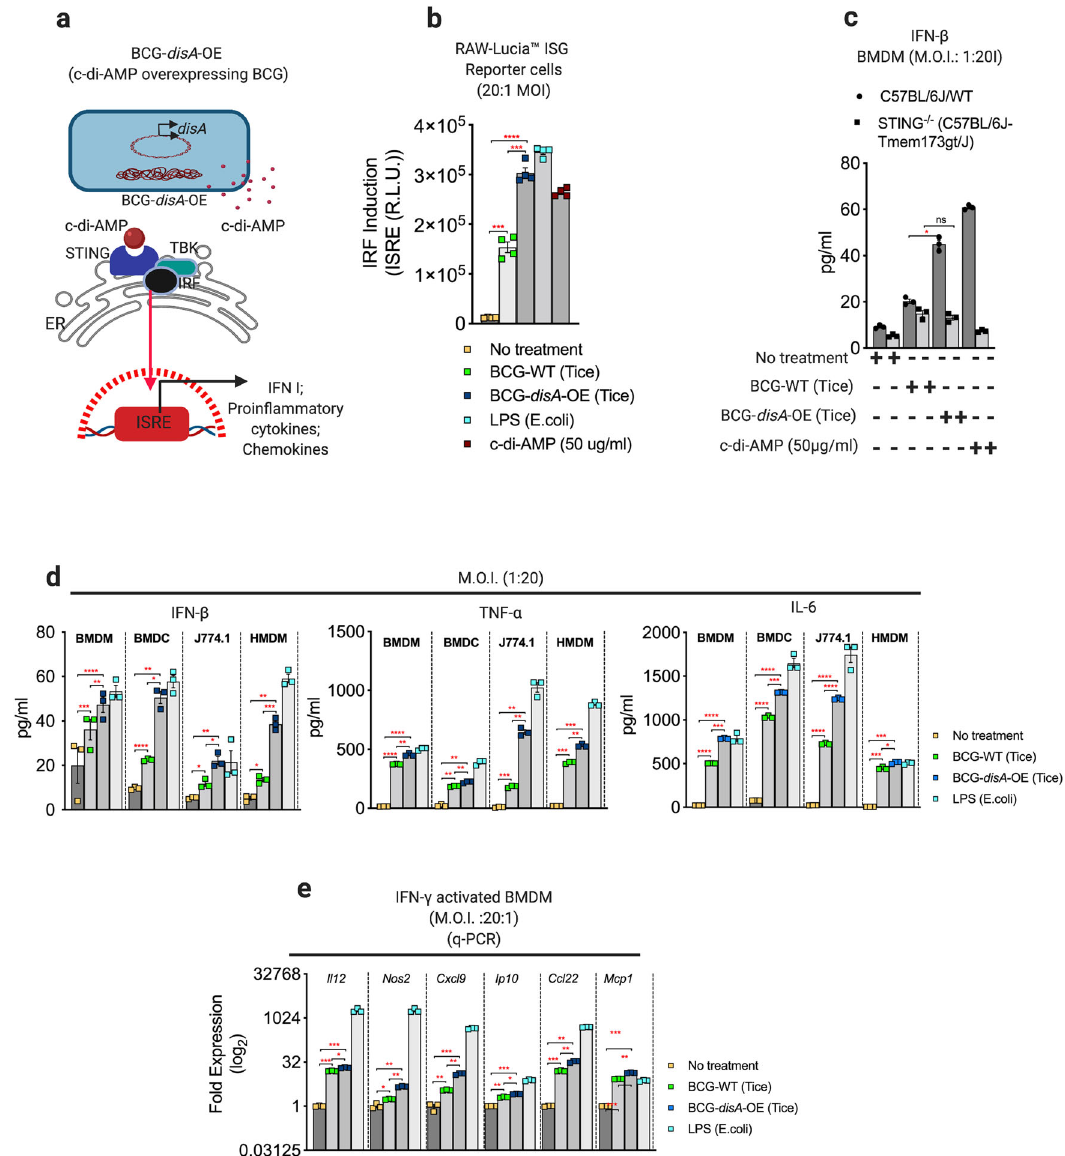
Fig. 1 BCG- disA -OE elicits greater pro-in fl ammatory cytokine responses than BCG-WT in primary human and murine macrophages and dendritic cells in vitro. a Schematic diagram. b IRF3 induction measured in RAW-Lucia ISG reporter macrophages. c IFN- β levels in murine BMDM from wild-type and STING − / − mice. d IFN- β , TNF- α , and IL-6 levels from primary human and murine macrophages and dendritic cells and the J774.1 murine macrophage cell line. e mRNA levels for Th1 cytokines and chemokines in murine BMDM relative to β -actin. Cytokine levels were measured by ELISA after 24 h exposures at a MOI of 20:1. Transcript levels were measured at 6 h after infection. Data are presented as mean values ± S.E.M. ( n = 3 biological replicate experiments). Statistical analyses done using two-tailed Student ’ s t -test (* P < 0.05, ** P < 0.01, *** P < 0.001, **** P < 0.0001). Data shown are for BCG-Tice; similar fi ndings were observed for BCG-Pasteur as shown in Fig.